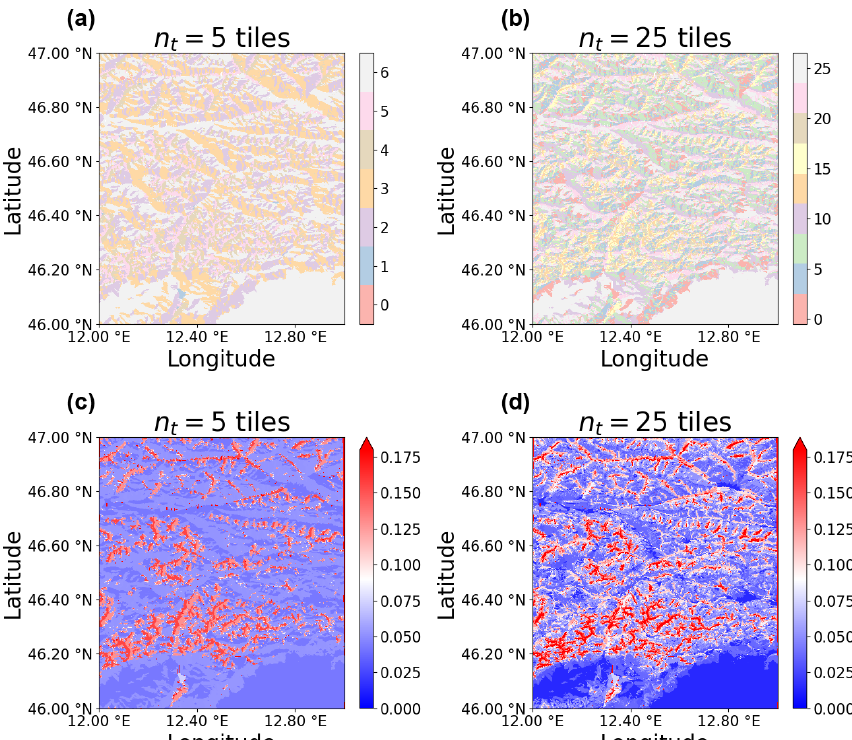
Figure 9. Effect of a different number of tiles for modeling the sub-grid variability of terrain properties over the study site. (a, b) Spatial distribution of the tiles representing homogeneous land units. Note that for this domain, in addition to the n t land clusters, there are two additional tiles corresponding to glaciers (tile 0) and lakes (tile 1), so that the resulting number of land units is 7 and 27 for (a) and (b) , respectively. (c, d) Spatial distribution of the terrain view factor ( ˜ C t ) locally averaged over each